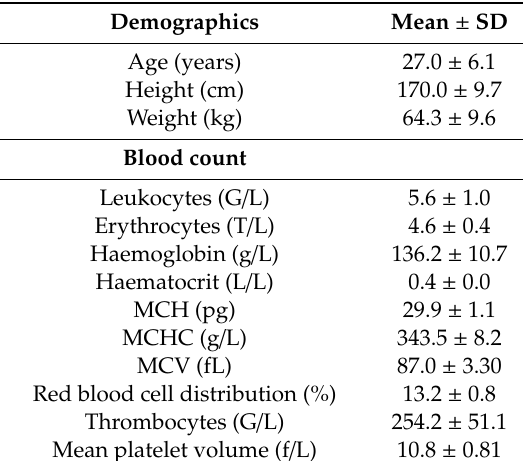
Table 1. Baseline parameters of all subjects ( n = 14).